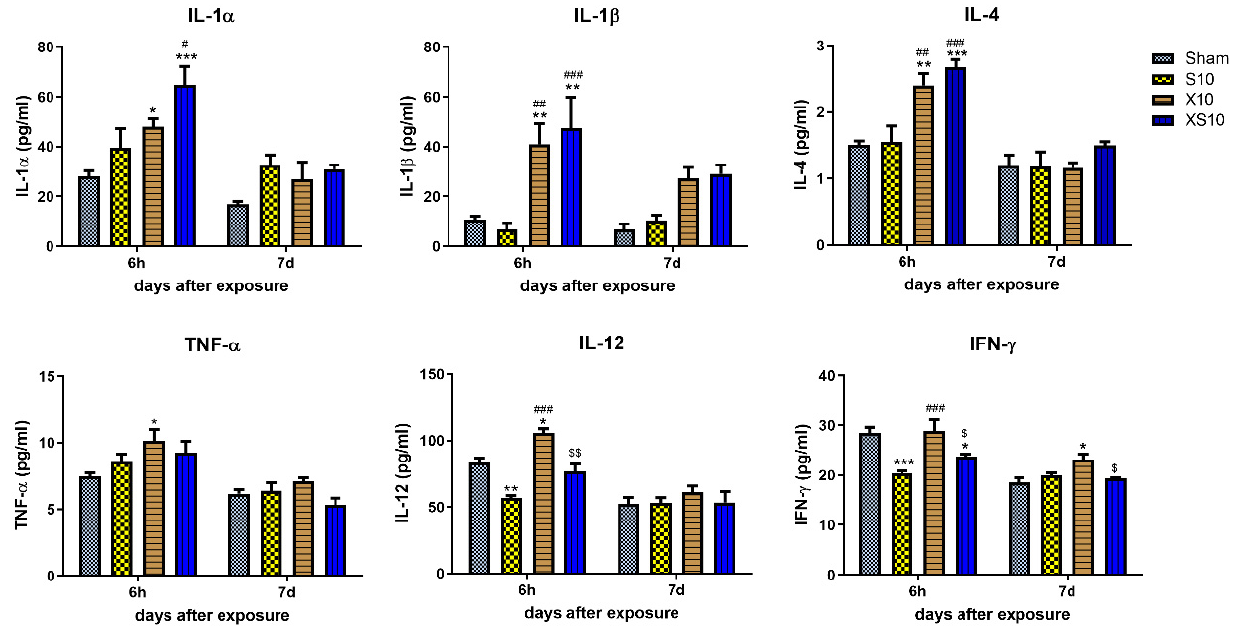
Figure 3. Microwave exposure regulated cytokine levels in peripheral blood. At 6 h and 7 d after microwave exposure, peripheral blood was collected from rats in the Sham, S10, X10 and XS10 groups. The serum was isolated by centrifugation. The concentrations of cytokines (IL-1 α , IL-1 β , IL-4, TNF- α , IL-12, IFN- γ ) were analyzed by multiplex immunoassays using a commercial Luminex immunoassay kit according to the manufacturer’s instructions. Data are shown as mean ± s.e.m.; *, p < 0.05, **, p < 0.01, ***, p < 0.001, vs. Sham group; #, p < 0.05, ##, p < 0.01, ###, p < 0.001, vs. S10 group; $, p < 0.05, $$, p < 0.01, vs. X10 group.